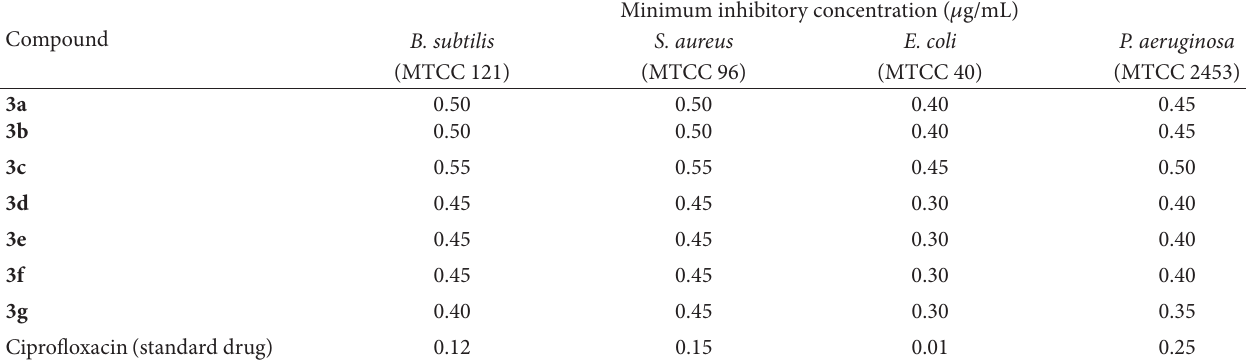
T 1: In vitro antibacterial activity of 1-phenyl-3-(4-(2-ethanoloxy)phenyl)-5-aryl-1